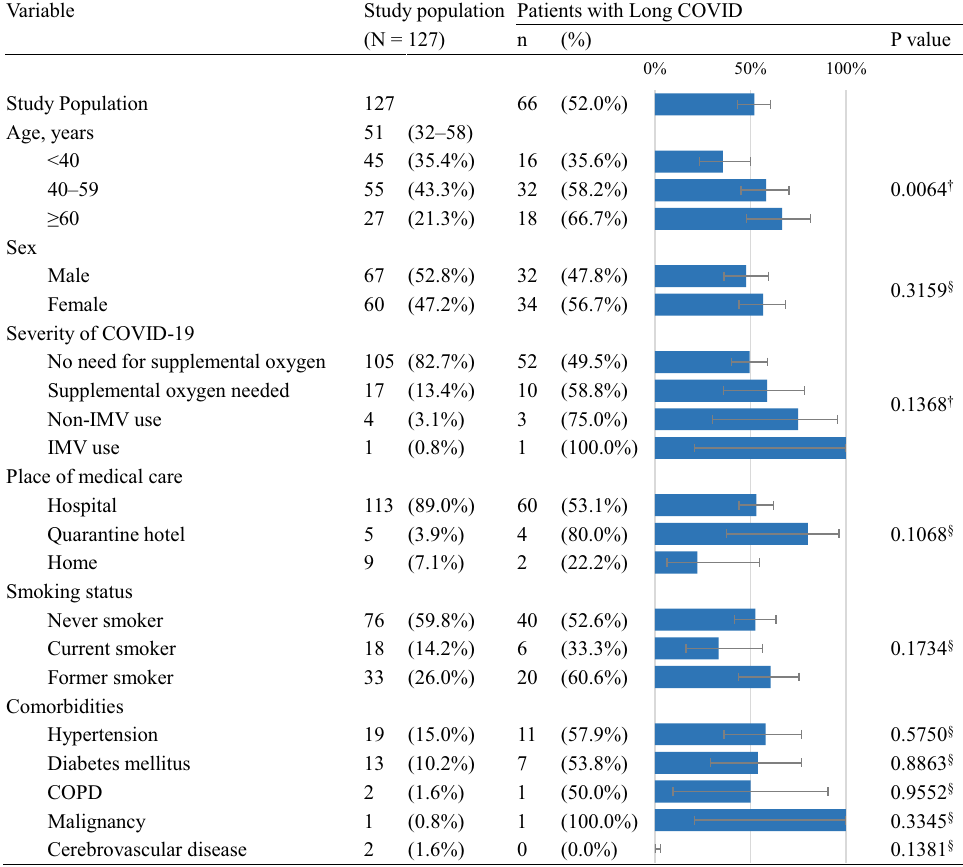
Table 1. Patient characteristics and prevalence of Long COVID. Data in the “Study population” column represent the numbers and percentages of relevant patients or median values and their interquartile ranges. Data in the “Patients with Long COVID” section represent the numbers and percentages of patients reporting persistent symptoms at a median of 29 days [IQR 23–128] after COVID-19 onset. Non-IMV non-invasive mechanical ventilation, IMV invasive mechanical ventilation, COPD chronic obstructive pulmonary disease. † Cochran–Armitage trend test. §Chi-square or Fisher’s exact